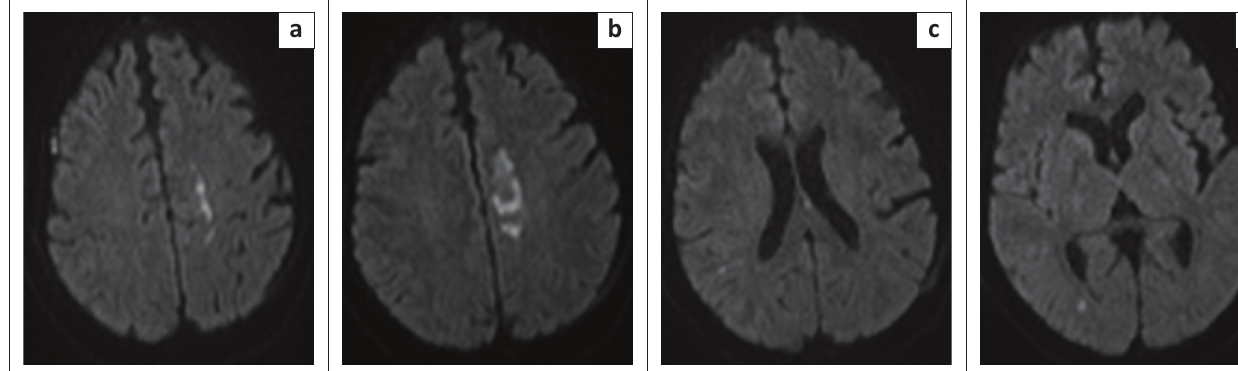
FIGURE 8: Axial DWI b1000 MR images (a–d).